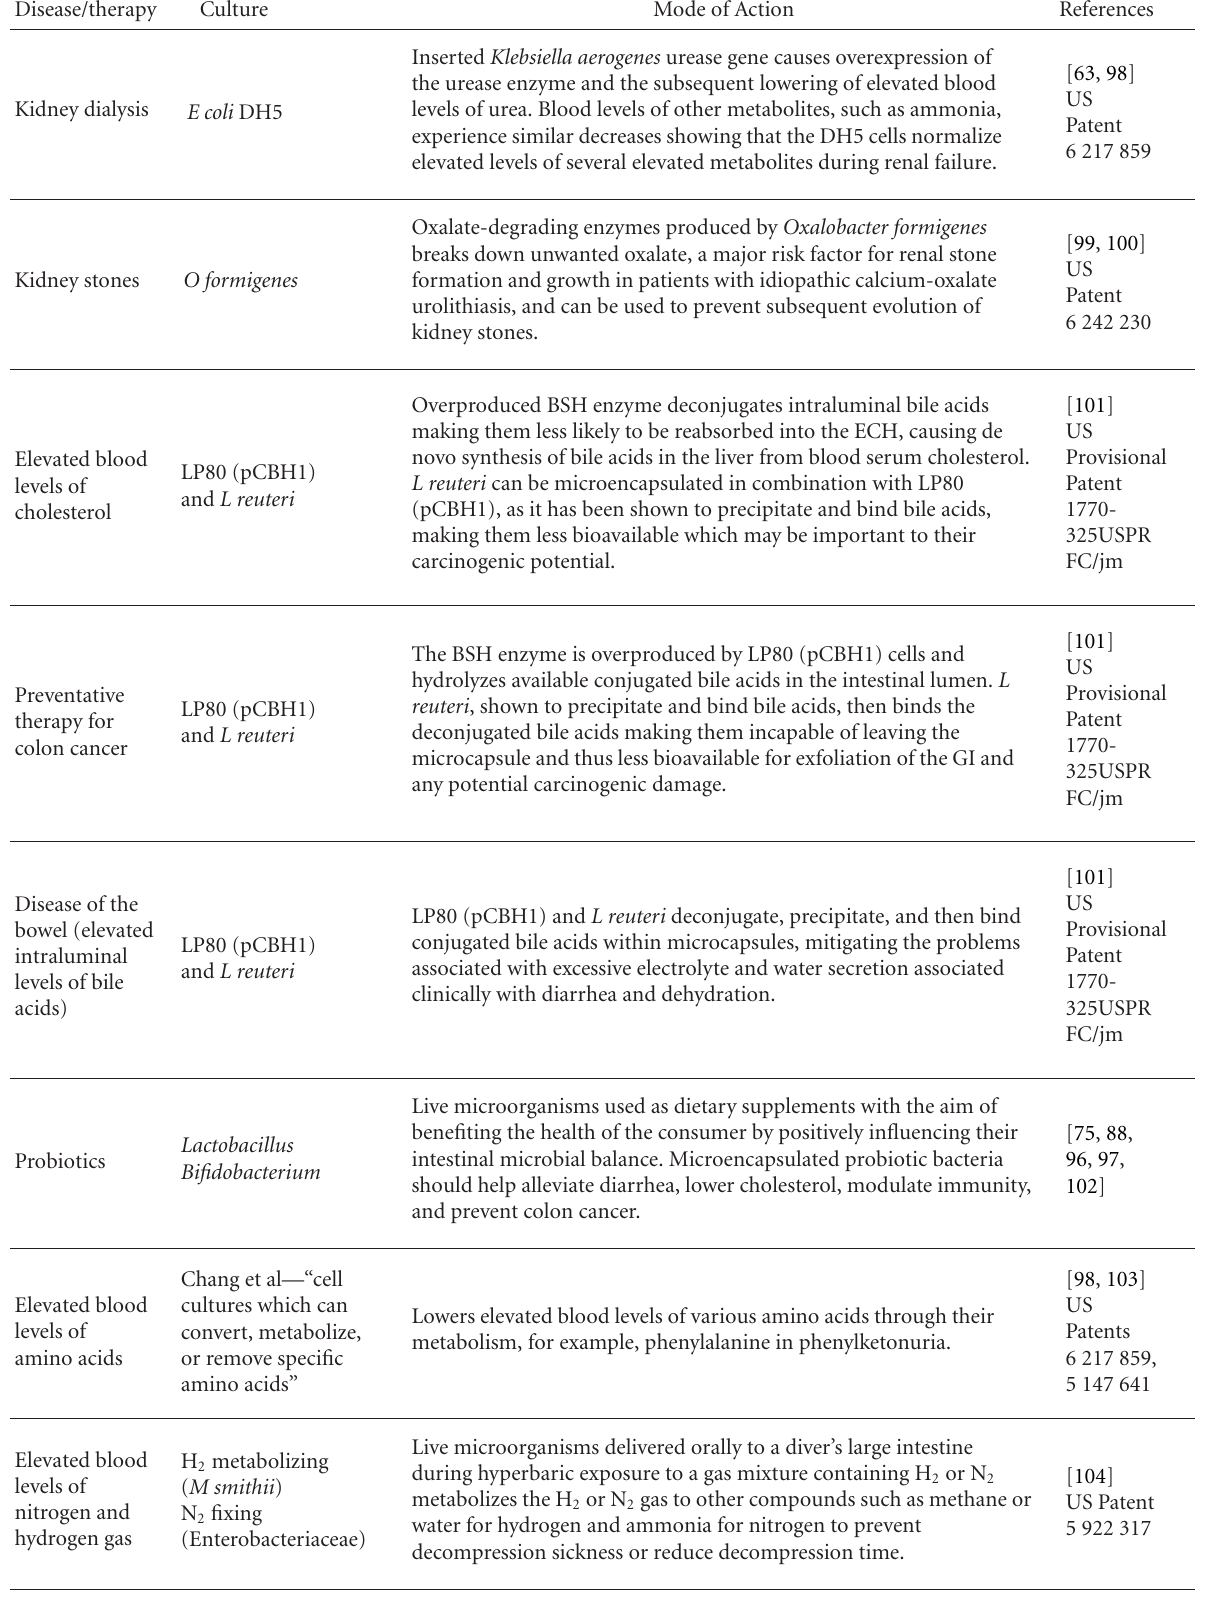
Table 2. Potential therapies based on the oral delivery of microencapsulated bacterial cells.